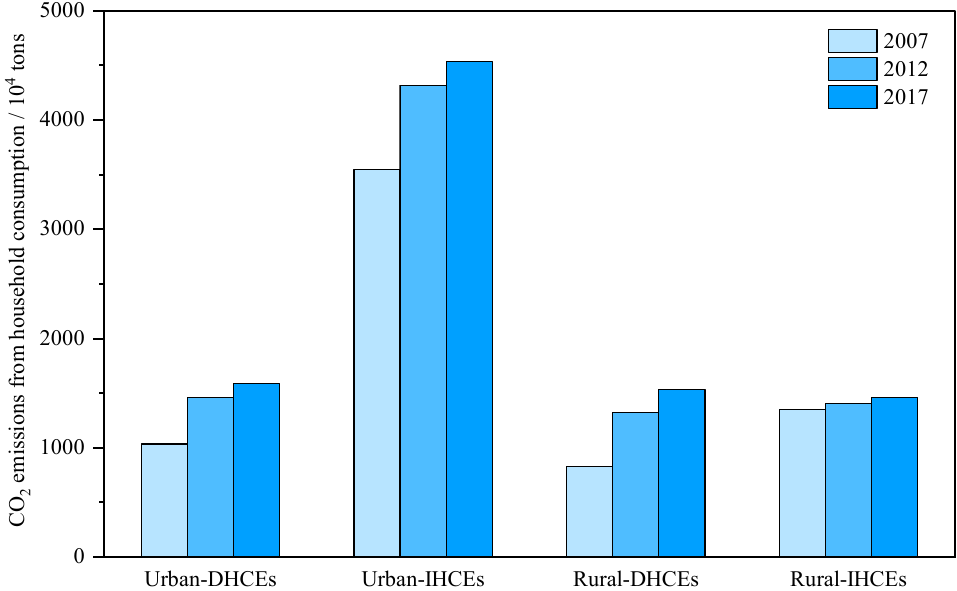
Figure 3. Urban–rural CO 2 emissions from household consumption in Fujian province.